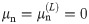
(a) A burst of cells is triggered by a single HSC differentiation event at time t = 0. A plot of representative solutions to Eqs (10) and (11) for rn = 2.5, L = 24, μn=μn(L)=0, μm = 1, Ass+=14.7, and ω = 0.16. Curves of different colors represent nb(ℓ)(t), the progenitor cell population within each generation ℓ = 0, 1, 2, …, L, and mb(t), the number of mature granulocytes associated with the differentiation burst. All populations rise and fall. (b) Realizations of peripheral blood (PB) populations in a single clone arising from multiple successive differentiation events. The fluctuating populations are generated by adding together mb(t) associated with each differentiation event. Time series resulting from small (hi/H+ = 0.0003) and large (hi/H+ = 0.03) HSC clones are shown. Small clones are characterized by separated bursts of cells, after which the clone vanishes for a relatively long period of time. The number of mature peripheral blood cells of large clones reaches a relatively constant level and almost never vanishes.